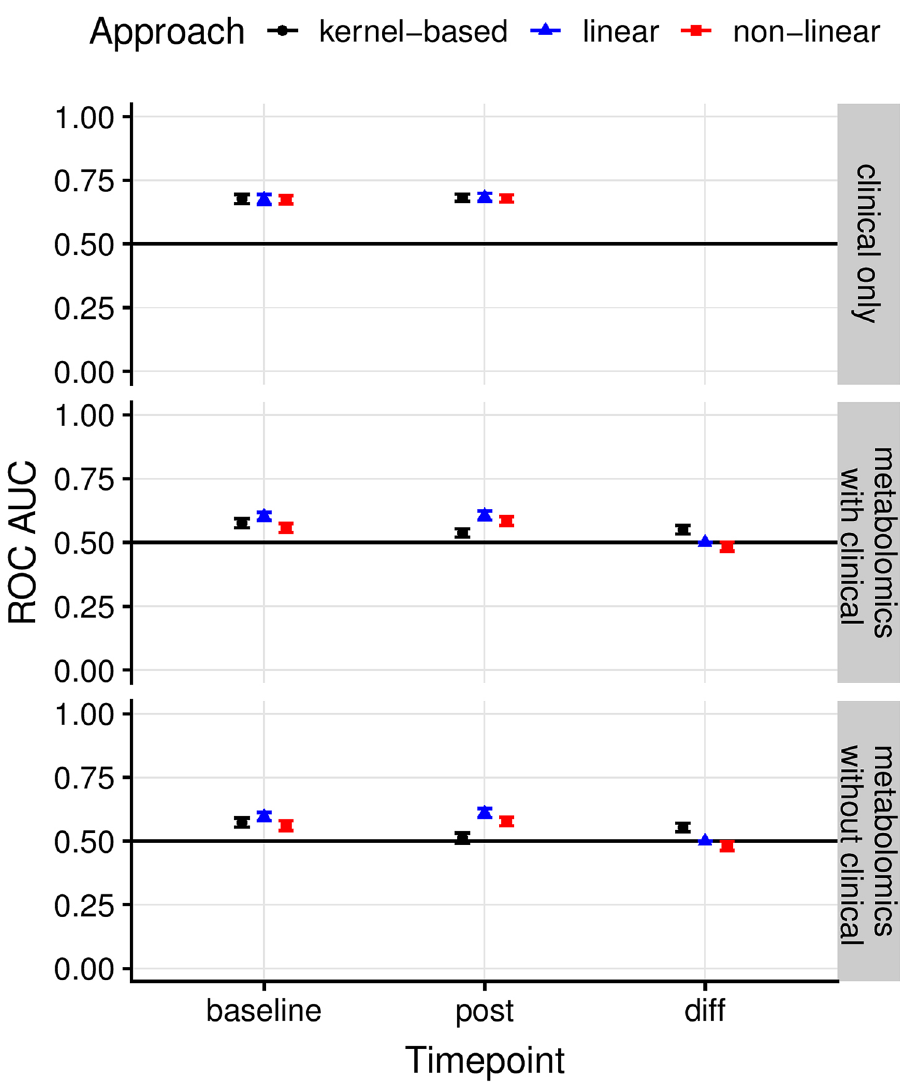
Figure 1. Average ROC AUCs across the cross-validation runs from three machine learning methods including: regularised regression, random forest and a pathway ‐ supported approach described previously (15). The three methods are labelled linear, non-linear and kernel-based, respectively. Clinical only: performance of models based on clinical data only, recorded at baseline and following 3 months on drug. Metabolomics with clinical: performance of models based on clinical variables plus lipid levels measured at baseline following 4 weeks on drug, and using the ratio of lipid levels between 4 weeks and baseline. Metabolomics without clinical: performance of models based on lipid levels